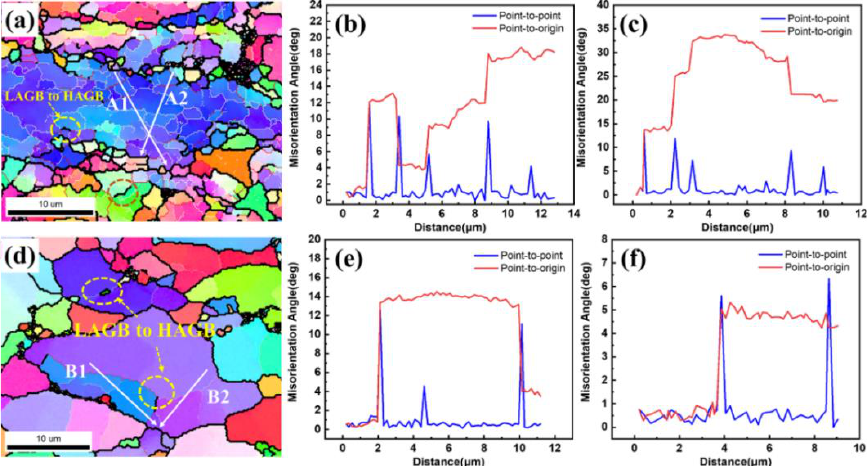
Figure 14. OIM micrographs and orientation analysis of the 13Zn alloy deformed to a 0.69 true strain at different temperatures with a strain rate of 0.1 s −1 : ( a ) Typical OIM micrograph at a deformed temperature of 300 °C, ( b , c ) misorientations measured along the lines A1 and A2 marked in ( a ); ( d ) Typical OIM micrograph at deformed temperature 420 °C, ( e , f ) misorientations measured along the lines B1 and B2 marked in ( d ).